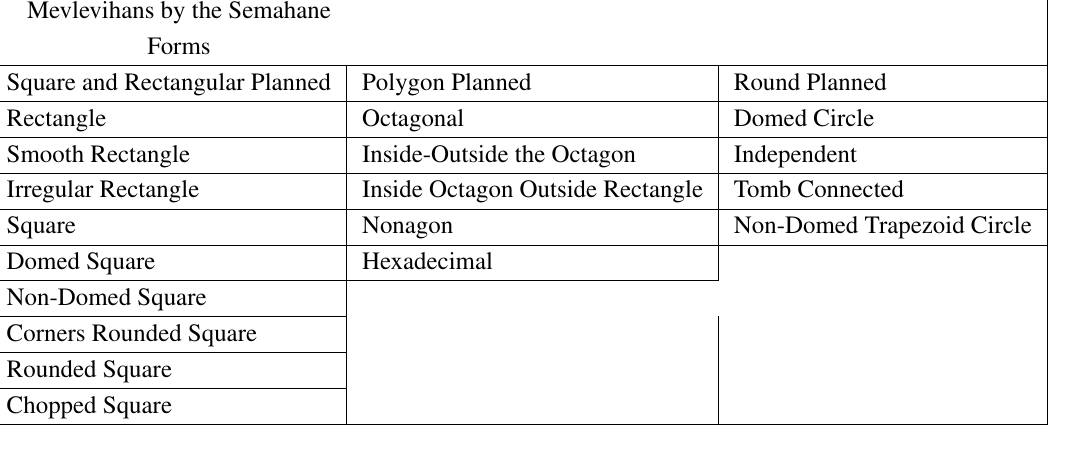
Table 2. Classification of the Mevlevihanes Accordingto the Settlement Layout (Tanrıkorur,